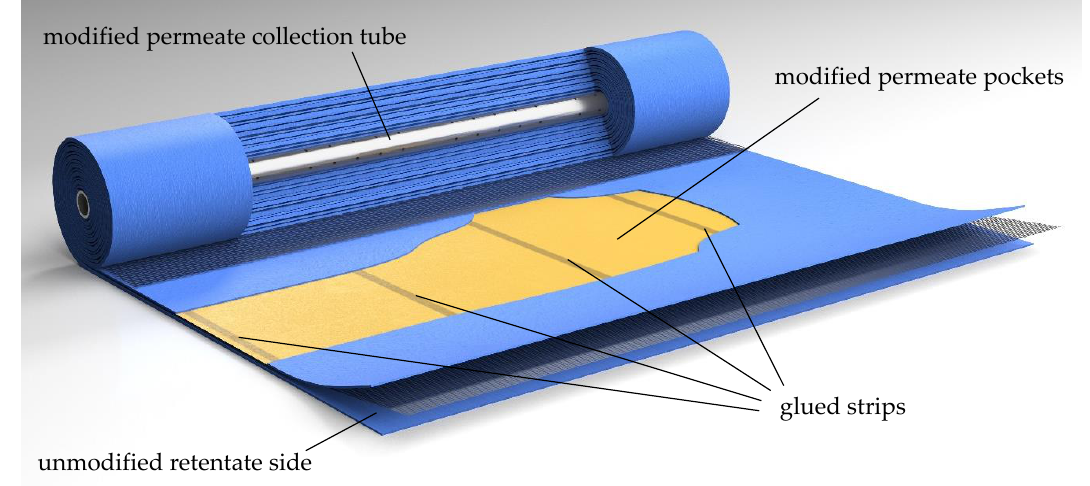
Figure 5. The sectioned module with modified permeate pockets and a modified permeate collection tube. The retentate side is unmodified. For comparison, an unmodified SWM can be found in the supplementary.